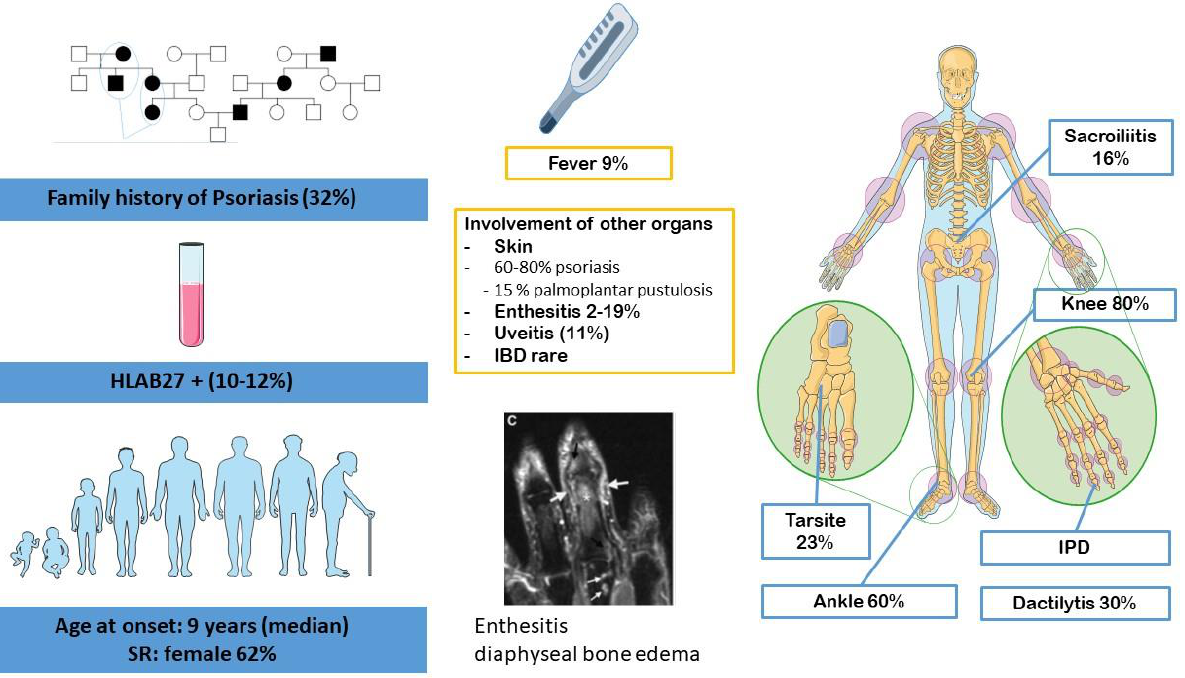
Table 1. Clinical characteristics of CRMO [23] and SpA